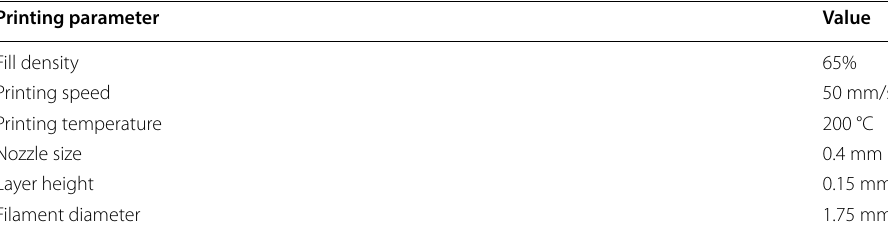
Table 1 3D printing